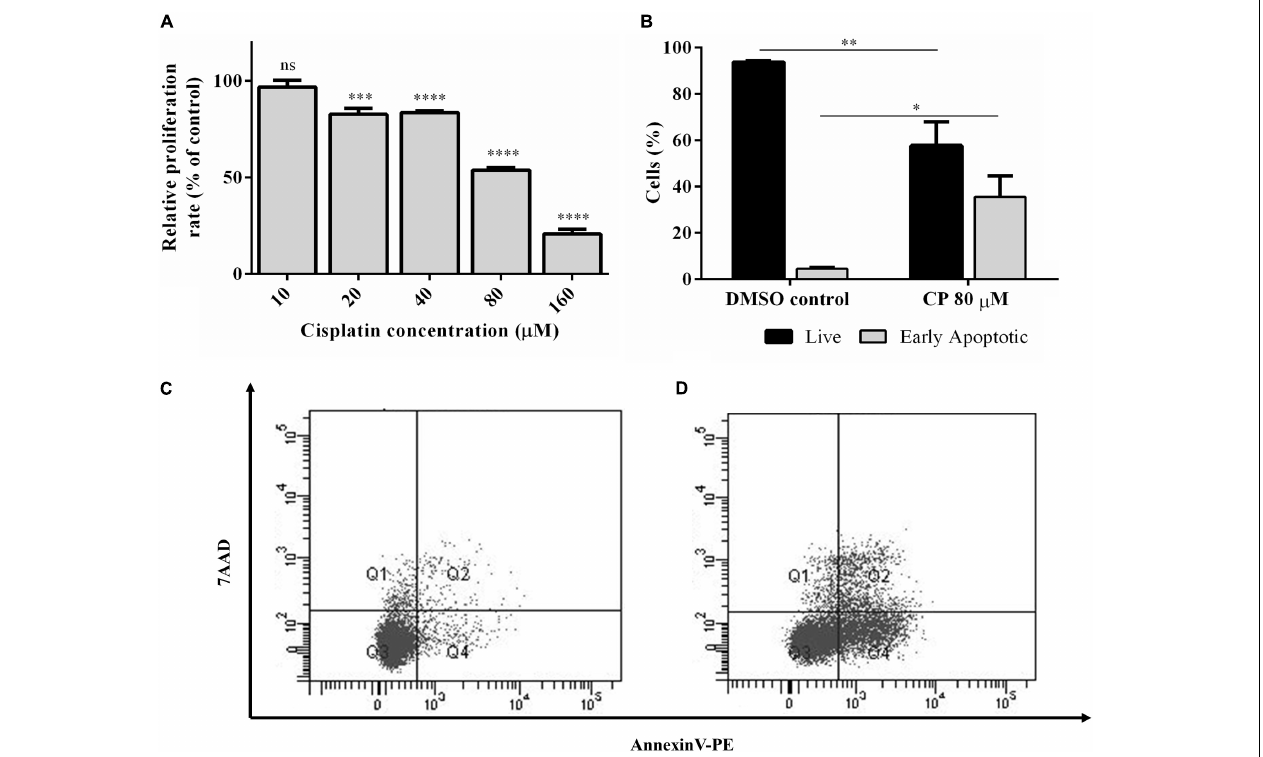
FIGURE 1 | Cisplatin-induced apoptosis and proliferation in HeLa cells. (A) Proliferation kinetics of HeLa cells. HeLa cells were treated with a range of cisplatin concentrations for 16 h and the proliferation rate was measured by WST-1 assay. (B) Percentage of live and early apoptotic population of HeLa cells. Hela cells were treated with 80 µ M cisplatin (CP) for 16 h and the rate of apoptotic cells were determined by Annexin-V and 7AAD staining. The stained cells were analyzed by flow cytometry. DMSO (0.1%) was used as negative control. (C,D) The population distributions of DMSO control and CP-treated groups as flow cytometry dot blot graphs, respectively. ns, non-significant, p > 0.05, ∗ p ≤ 0.05, ∗∗ p ≤ 0.01, ∗∗∗ p ≤ 0.001, and ∗∗∗∗ p ≤ 0.0001.